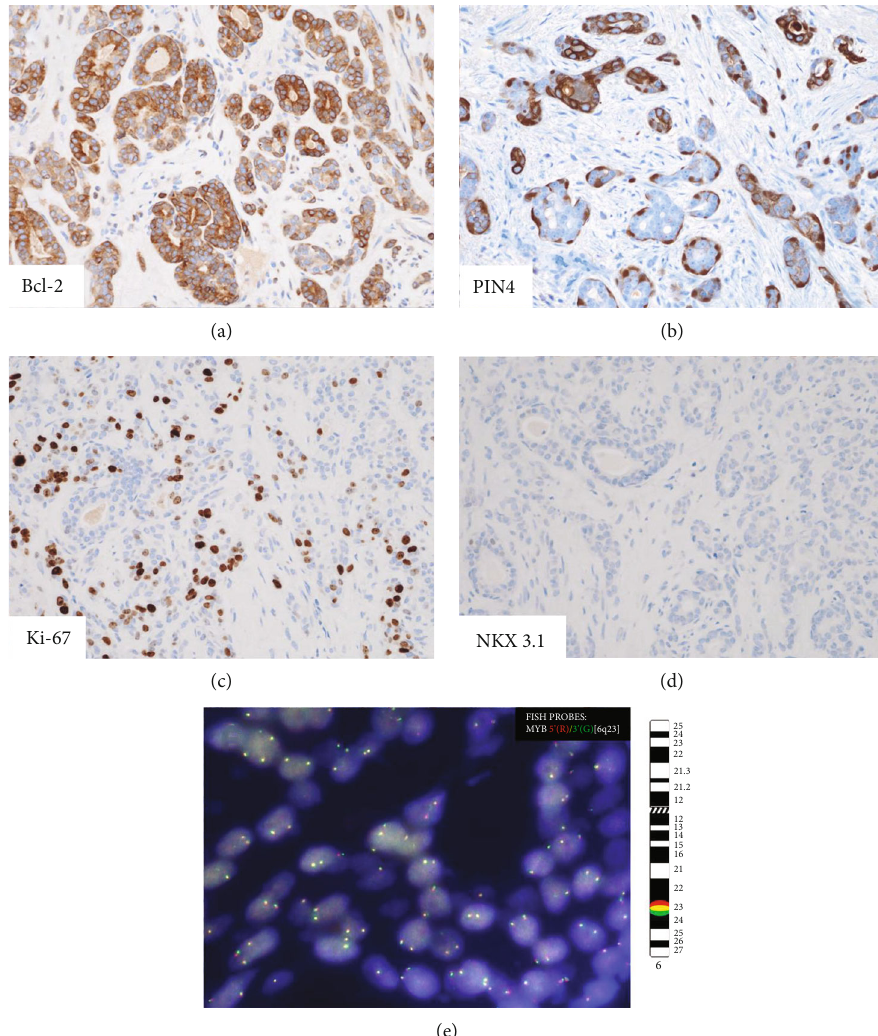
Figure 2: Immunohistochemistry and cytogenetics studies support the diagnosis of prostatic BCC. The tumor cells revealed strong and di ff use reactivity for Bcl-2 (a, 200x magni fi cation), variable multilayer reactivity for basal markers such as p63 and HMWCK (b, 200x magni fi cation). Ki-67 staining showed high proliferation of > 30% (c, 200x magni fi cation). The tumor was negative for NKX3.1 (d, 200x magni fi cation) and racemase (b, 200x magni fi cation). Break-apart FISH for MYB image did not show separation of 5 ′ MYB and 3 ′ MYB